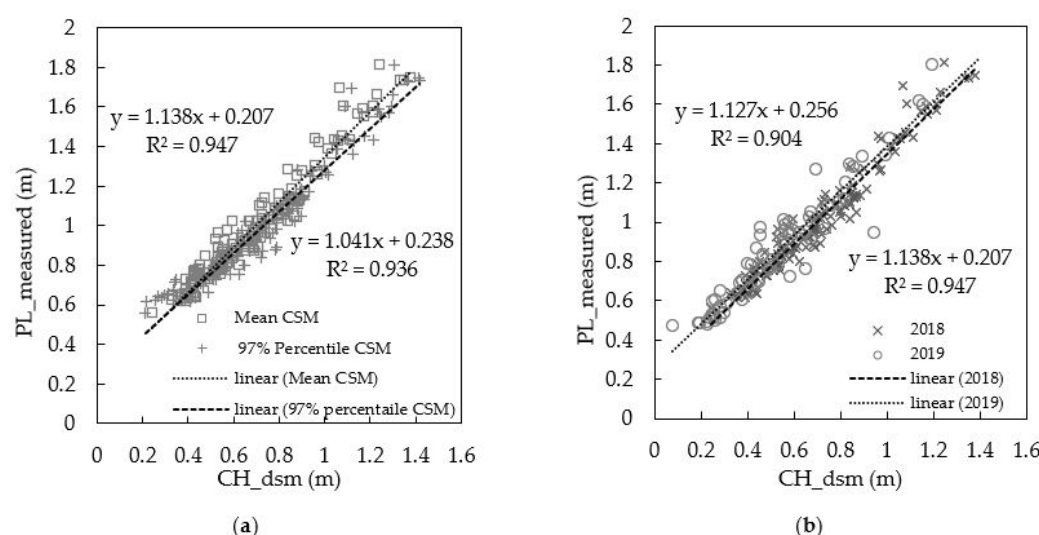
Figure 7. Comparison between; ( a ) measured plant length (PL) and two types of canopy heights (CH) calculated from the mean values and 97th percentile of CSM n and ( b ) the seasonal relationships between them.